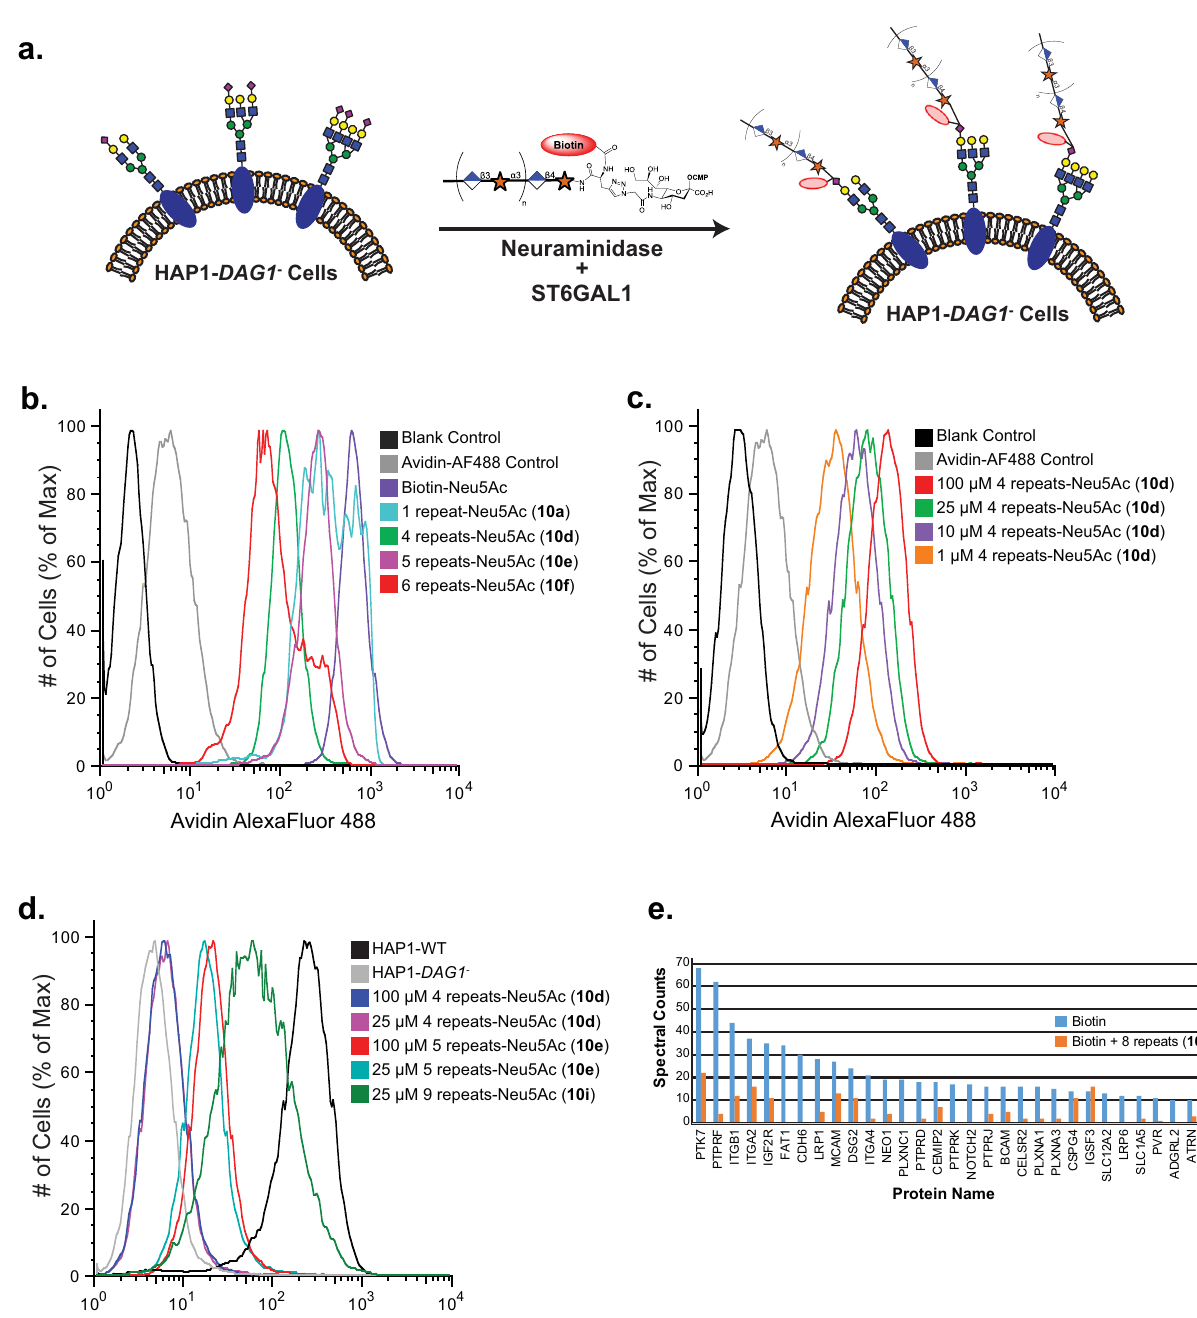
Fig. 4 Detection of matriglycan on HAP1- DAG1 - cells by fl ow cytometry. a CMP-Neu5Ac ’ s modi fi ed with de fi ned matriglycan polymeric repeats (100 μ M) are engineered on HAP1- DAG1 - cells using ST6GAL1 in the presence of C. perfringens neuraminidase. b Detection of matriglycan with 1, 4, 5, and 6 disaccharide repeats on HAP1- DAG1 - cells by fl ow cytometry. Cells were stained with avidin-AF488 and co-stained with PI to exclude non-viable cells. c Detection of matriglycan with 4 repeats at various concentrations of modi fi ed donor. d Binding of IIH6 to HAP1-WT and HAP1- DAG1 - matriglycan modi fi ed cells. e Shotgun proteomics analysis of proteins immunoprecipitated from HAP1- DAG1 - cells labeled with Biotin or Biotin + 8 disaccharide repeats. Proteins present in the negative control experiment (unlabelled cells), had fewer than 10 spectral counts in the CMP-Neu5Ac-(Biotin) labeling experiment, or known to be localized in intracellular compartments as assessed by UNIPROT annotations, were excluded. Proteins shown are all annotated in UNIPROT to contain sites of N -glycosylation or were manually validated to contain at least one N-X-(S/T) N -glycosylation sequon in the primary sequence. One representative run is shown. Three independent experiments were performed with similar results each time. Source data are provided as a Source Data fi (Fig. 2), the N-linked glycoprotein fetuin (Fig. 3, Supplementary core protein nor the elaborated underlying O -mannosylation Fig. 3), or on a cell surface (Figs. 4 and 5), despite an apparent glycan is required. lower transfer by ST6GAL1 with increasing length at equimolar It is well-known that anti-carbohydrate antibodies recognize concentrations. It demonstrates that neither the underlying α -DG relatively small epitopes ranging from 3 to 7 monosaccharides,